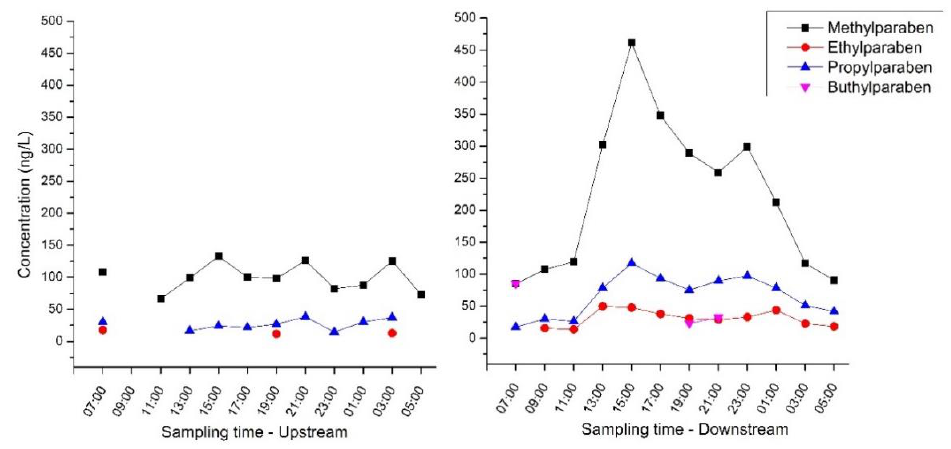
Figure 3. Daily variation of methylparaben, ethylparaben, propylparaben, and